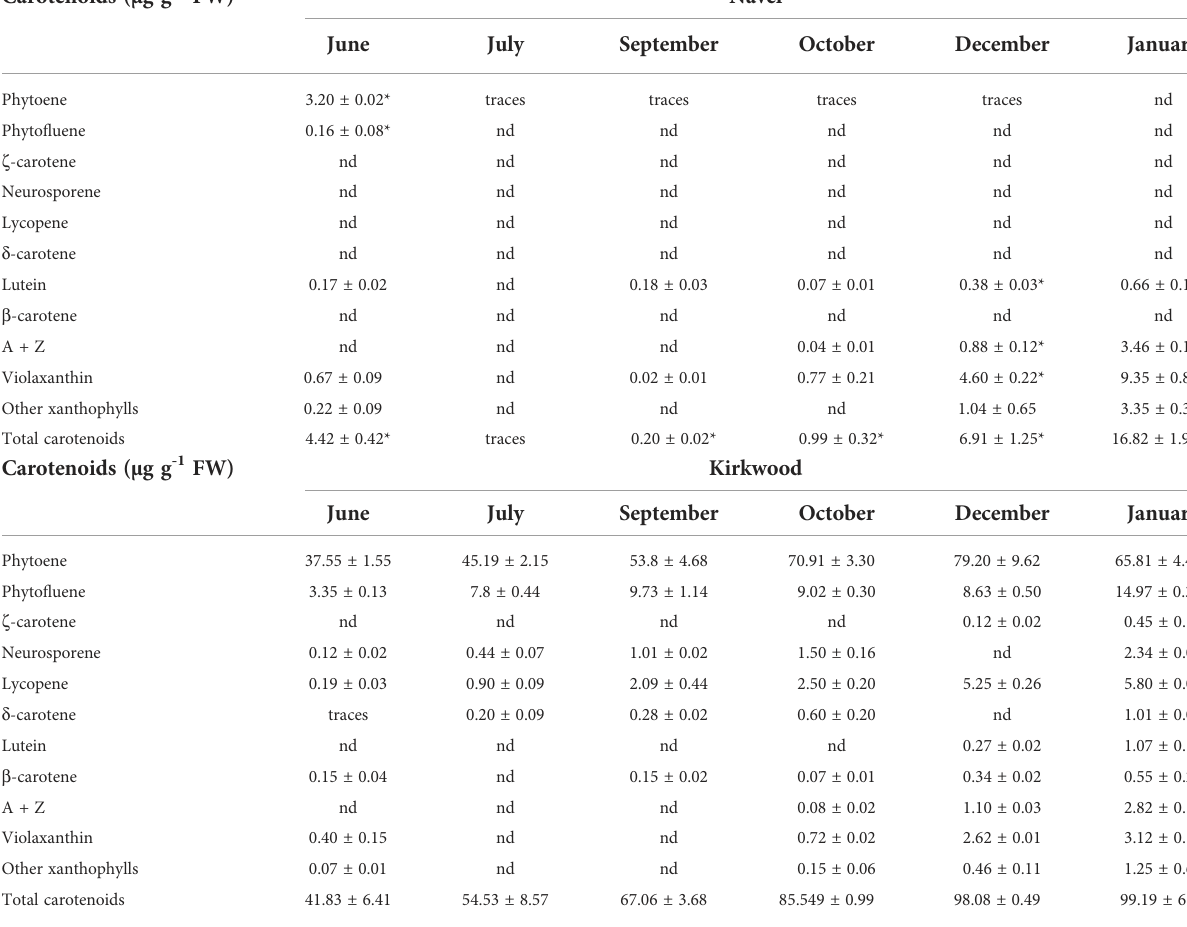
TABLE 1 Carotenoid content and composition (µg g -1 FW) in the pulp of Navel and Kirkwood Navel at six different stages of development and maturation. Carotenoids (µg g -1